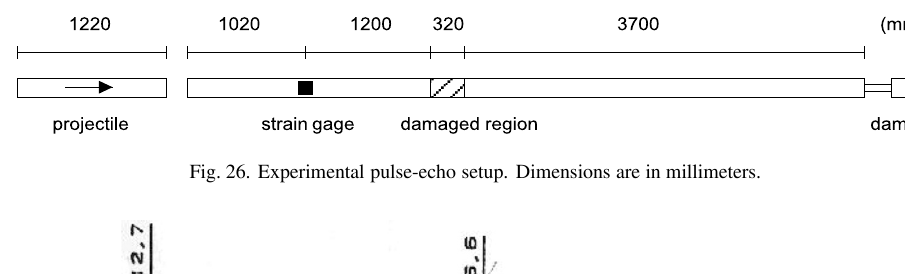
Fig. 25. Effect of modeling errors in the damage identi fi cation.